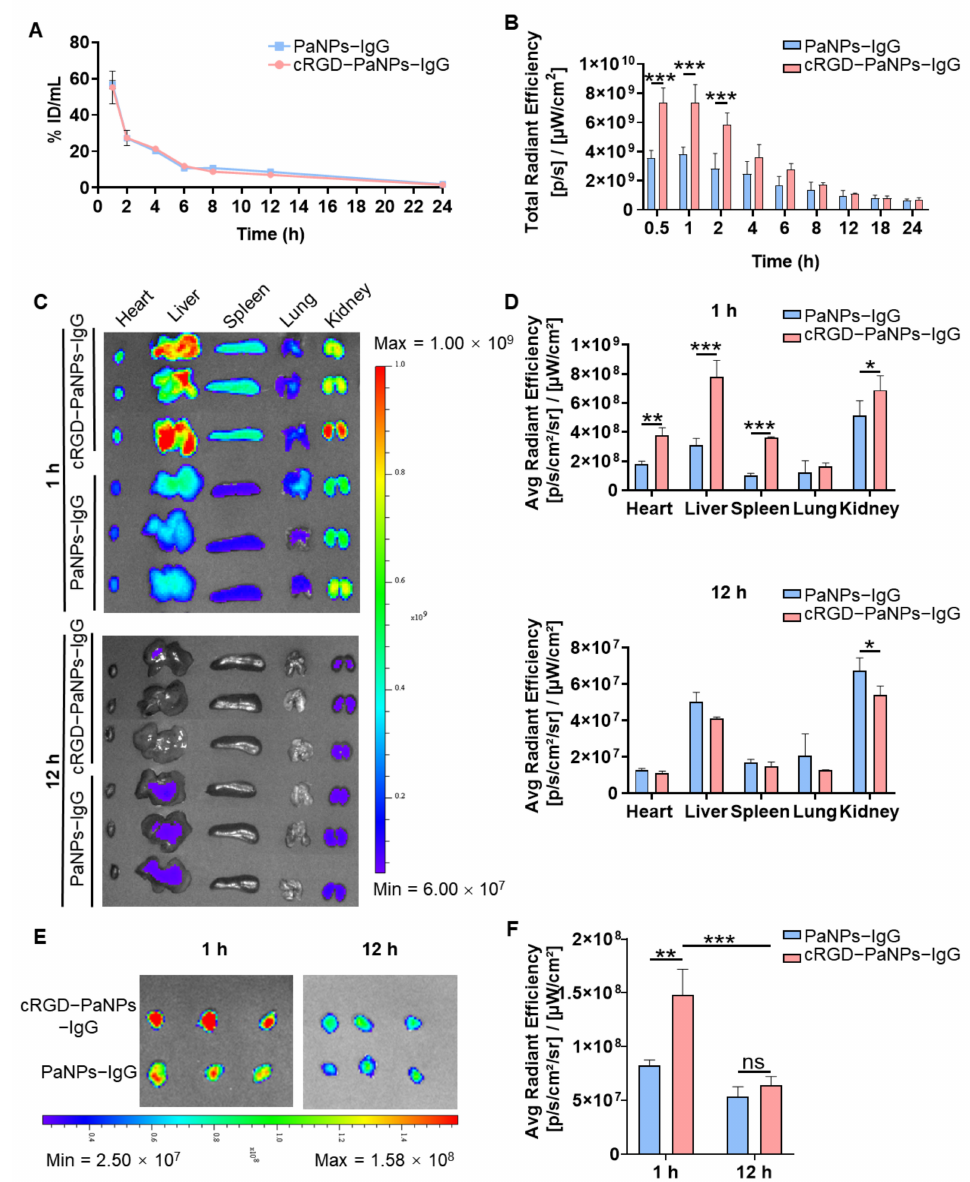
Figure 4. Biodistribution of Pa from PaNPs–IgG or cRGD–PaNPs–IgG in the 4T1–bearing mice. The mice were i.v. injected with PaNPs–IgG or cRGD–PaNPs–IgG (5 mg/kg of Pa, 5 mg/kg of IgG). ( A ) The blood concentration–time curves of Pa in healthy BALB/c mice. ( B ) The semi–quantitative analysis of fluorescence intensity of Pa in the tumor of mice. ( C ) Fluorescence images of main organs from 4T1–bearing mice at 1 h or 12 h after the injection. ( D ) Semi–quantitative analysis of the imaging results in ( C ). ( E ) Fluorescence images of the tumors at 1 h or 12 h after the i.v. injection. ( F ) Semi–quantitative analysis of the imaging results in ( D ). Data are expressed as mean ± SD ( n = 3). * p < 0.05, ** p < 0.01 and *** p < 0.001. ns, no significant difference between the two compared